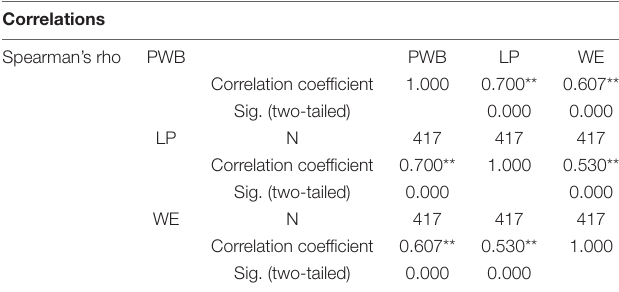
TABLE 3 | Correlation among for psychological well-being, loving pedagogy, work engagement. Correlations